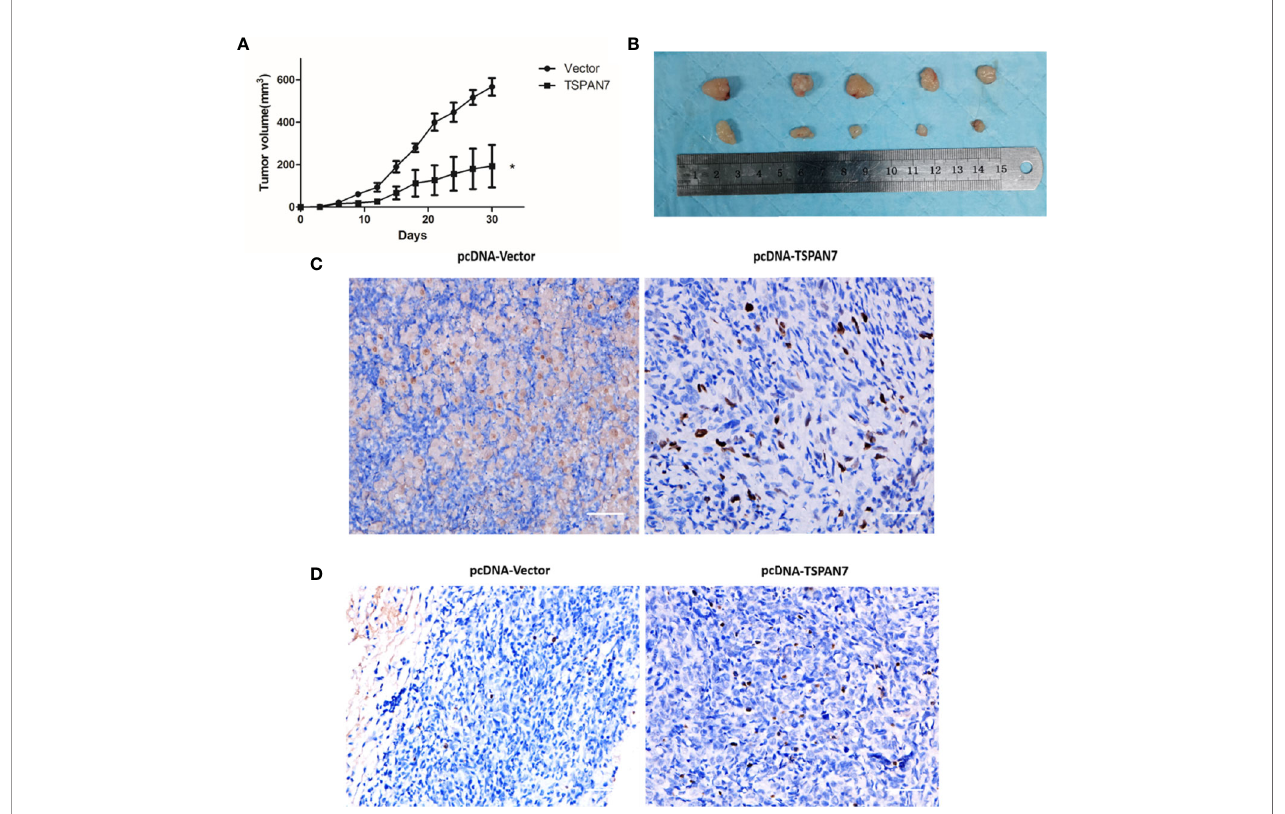
FIGURE 8 | Anti-tumor effects of in vivo . (A) Mean tumor volume at each time point. (B) Morphology of the subcutaneous implanted tumor. (C) Immunohistochemistry (IHC) was performed to detect the protein of Ki67 in the tumor tissue. (D) A TUNEL assay was performed to detect the apoptotic cells in the tumor tissue. *P < 0.05 vs. the control. All the above data are the mean ± SD from an average of three